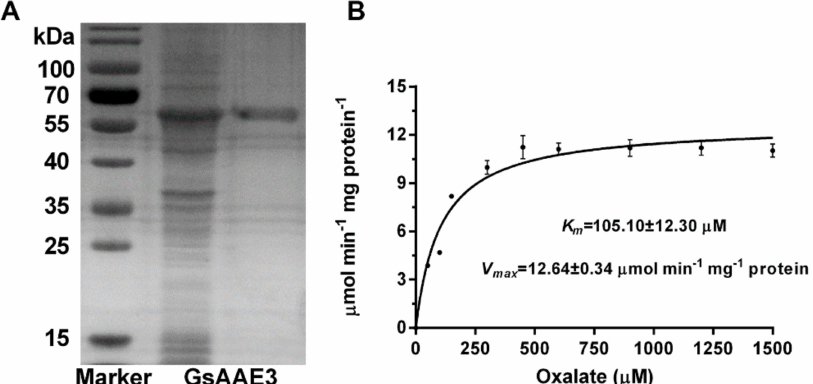
Figure 4. Biochemical analysis of GsAAE3 . ( A ) SDS-PAGE gel of Ni-NTA purified recombinant protein (right), unpurified recombinant (middle), and molecular weight markers (left). ( B ) Kinetic analysis of GsAAE3 using a range of oxalate concentrations. K m and V max were determined from non-linear regression to the Michaelis–Menten kinetics for concentrations up to 1500 µ M oxalate. Data are means ± SD of three independent biological